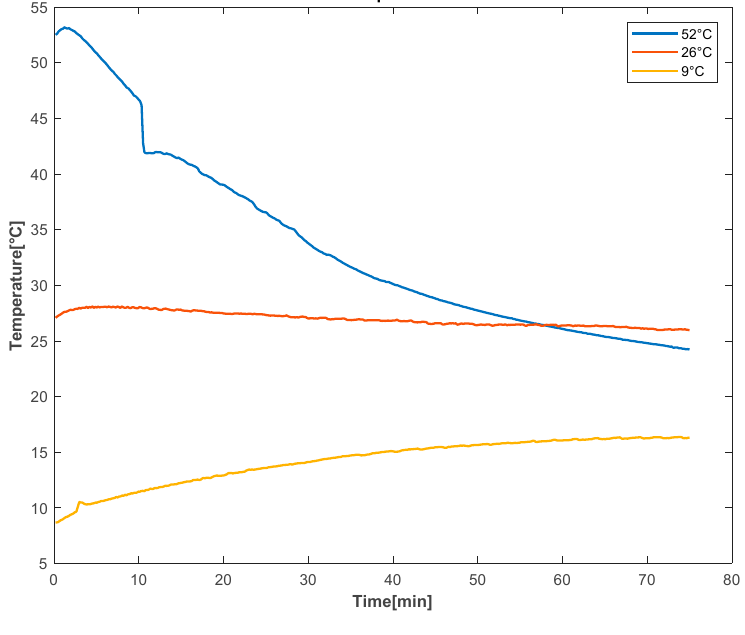
Figure 8. Electrolyte temperature change. Table 5. Experimental results according to initial temperature of the electrolyte.